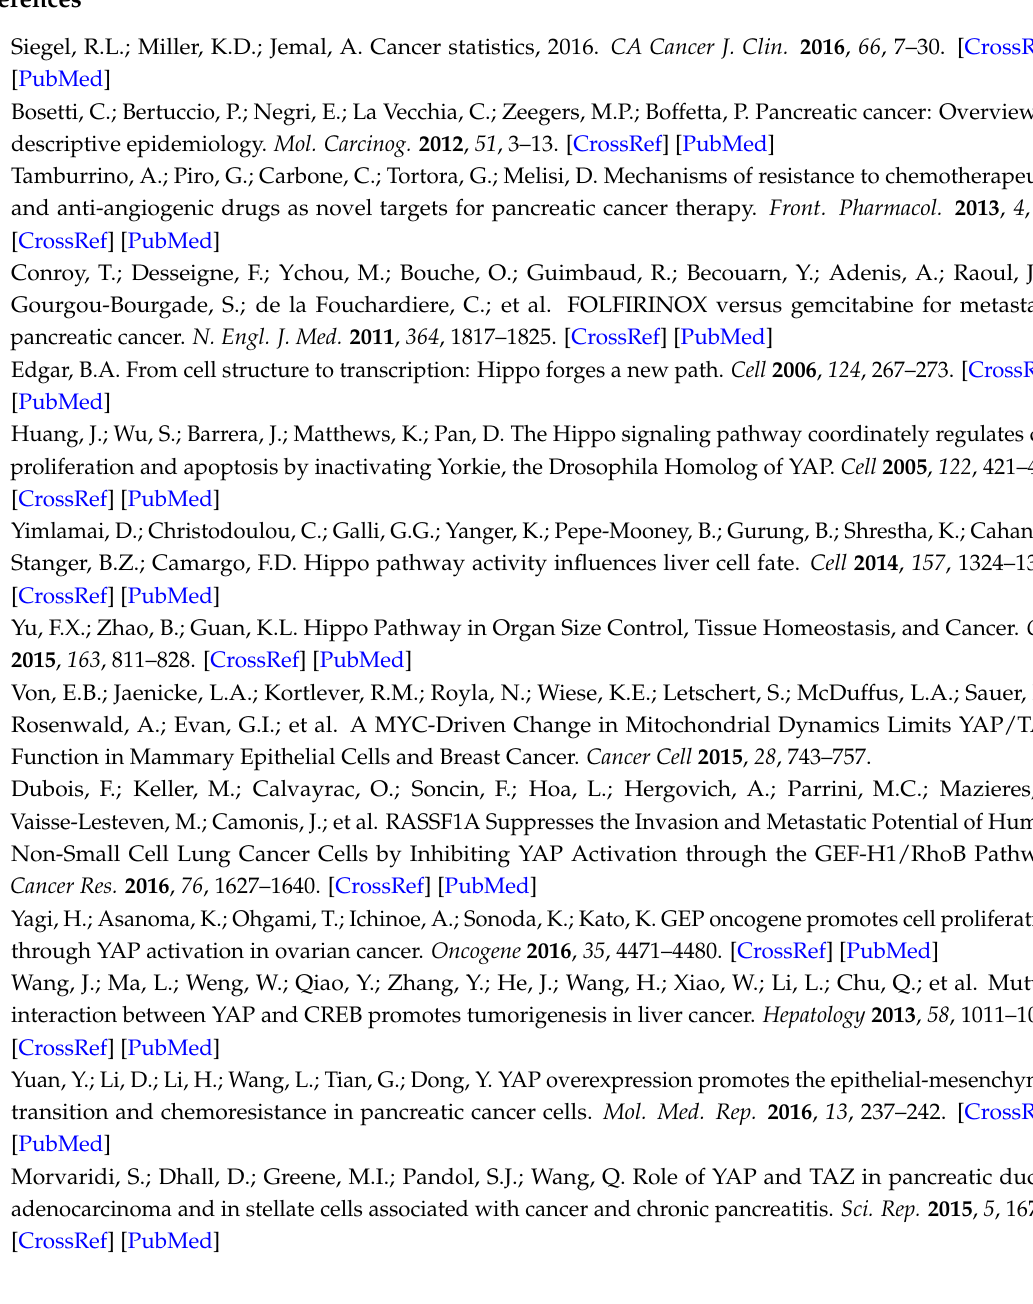
Table S1: A list of the utilized primary antibodies, Table S2: The siRNA sequences, Table S3: Primers sequences for real-time PCR